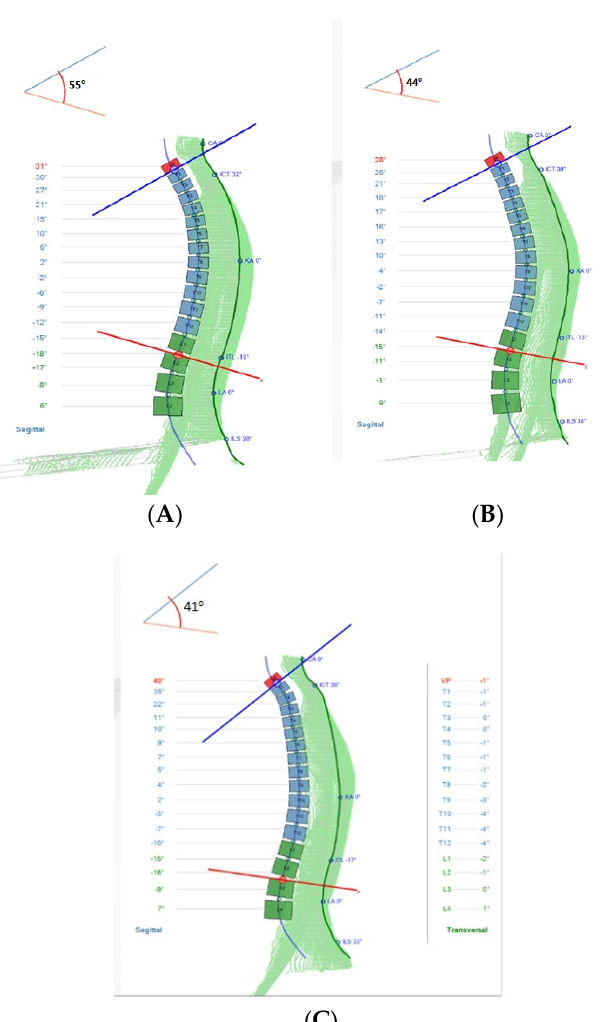
Figure 4. Kyphosis formetric posture alignment outcomes for a sample intervention group participant receiving the DTTO. ( A ) Initial baseline; ( B ) after 10-weeks and 30-sessions of intervention; and ( C ) the 1-year follow-up assessment where no further treatment was provided over the course of one year.